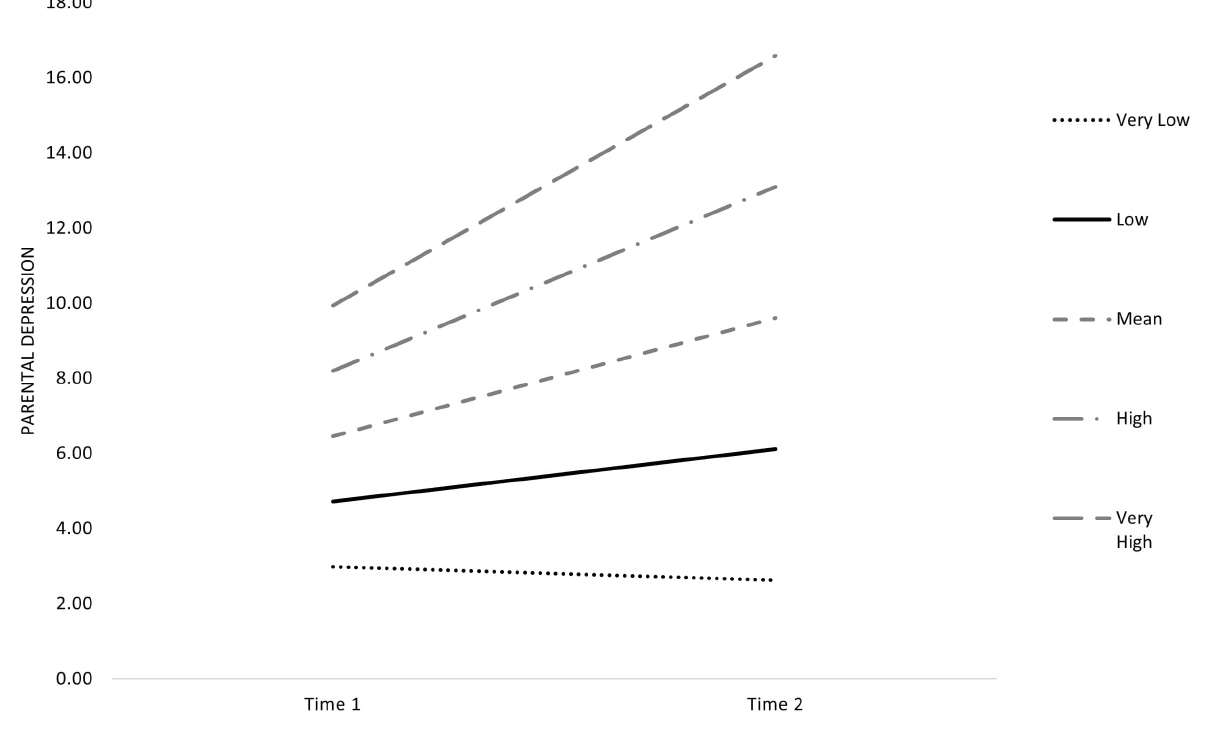
FIGURE 1 | Changes in parental depression according to self-criticism